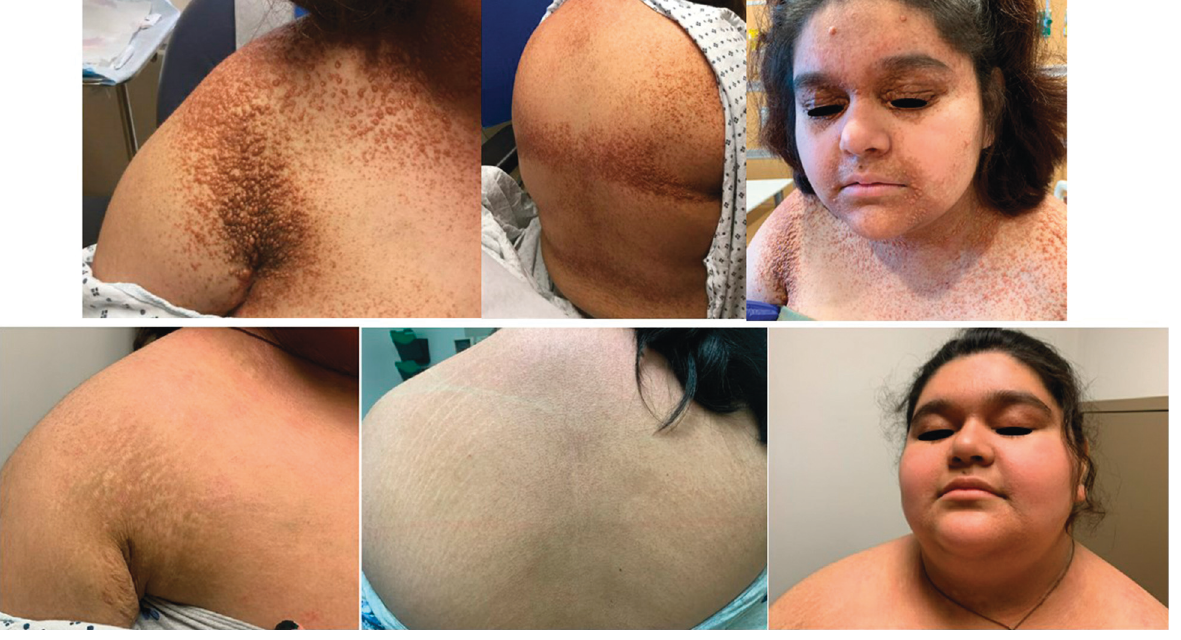
Figure 3: XD response to 2CdA on physical exam. Physical exam of characteristic involved regions just prior to starting 2CdA (top row). Physical exam of same regions at follow-up visit twenty months off-therapy (bottom